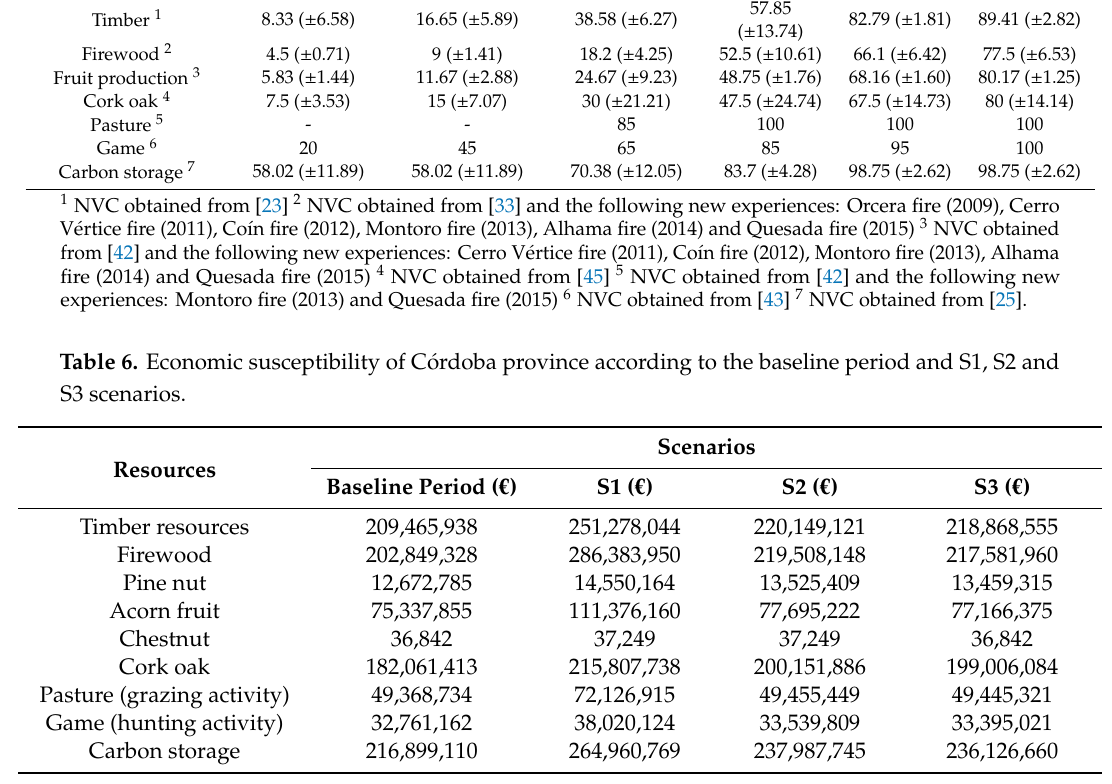
Table 5. Net value change (NVC) (%) of each resource based on fire intensity level (FIL). Resource